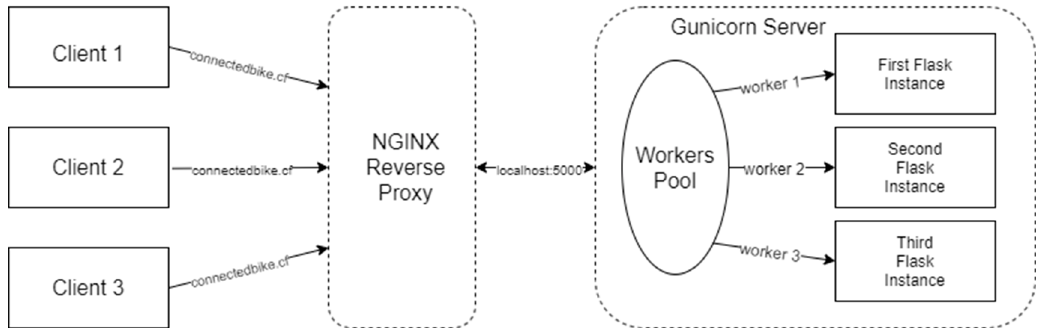
Figure 14. NGINX reverse proxy operation scheme.